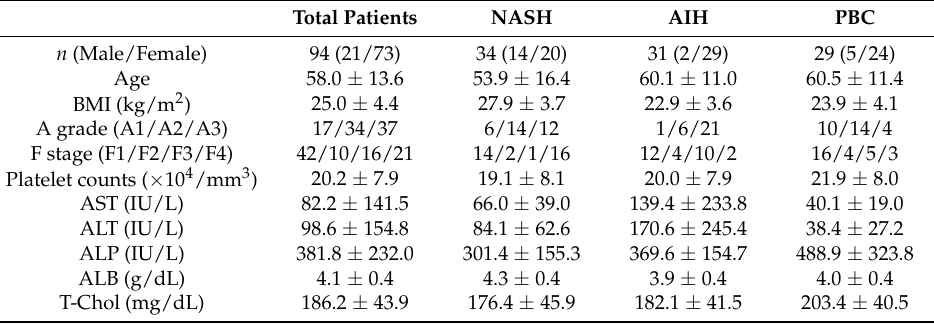
Table 1. Baseline characteristics of 94 patients with nonalcoholic steatohepatitis (NASH), autoimmune hepatitis (AIH), or primary biliary cholangitis (PBC) at liver